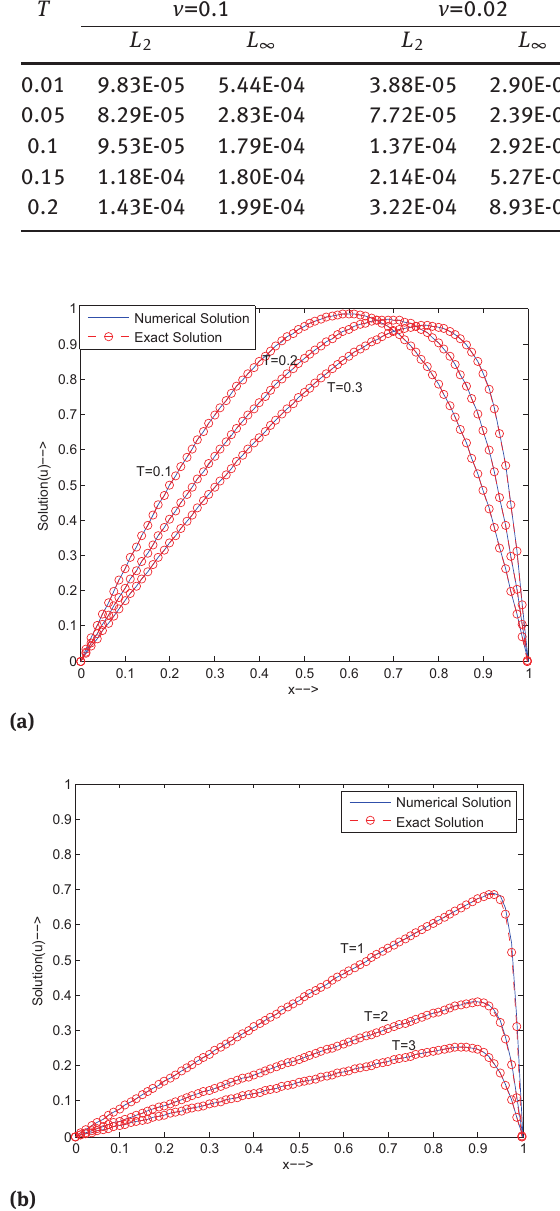
Fig. 4: Example 2: Numerical solutions at different times for Δx = 0.0125 and different values of ν and Δt , (a) ν = 0.02 , Δt = 0.0001 (b) ν = 0.01 , Δt = 0.001 .